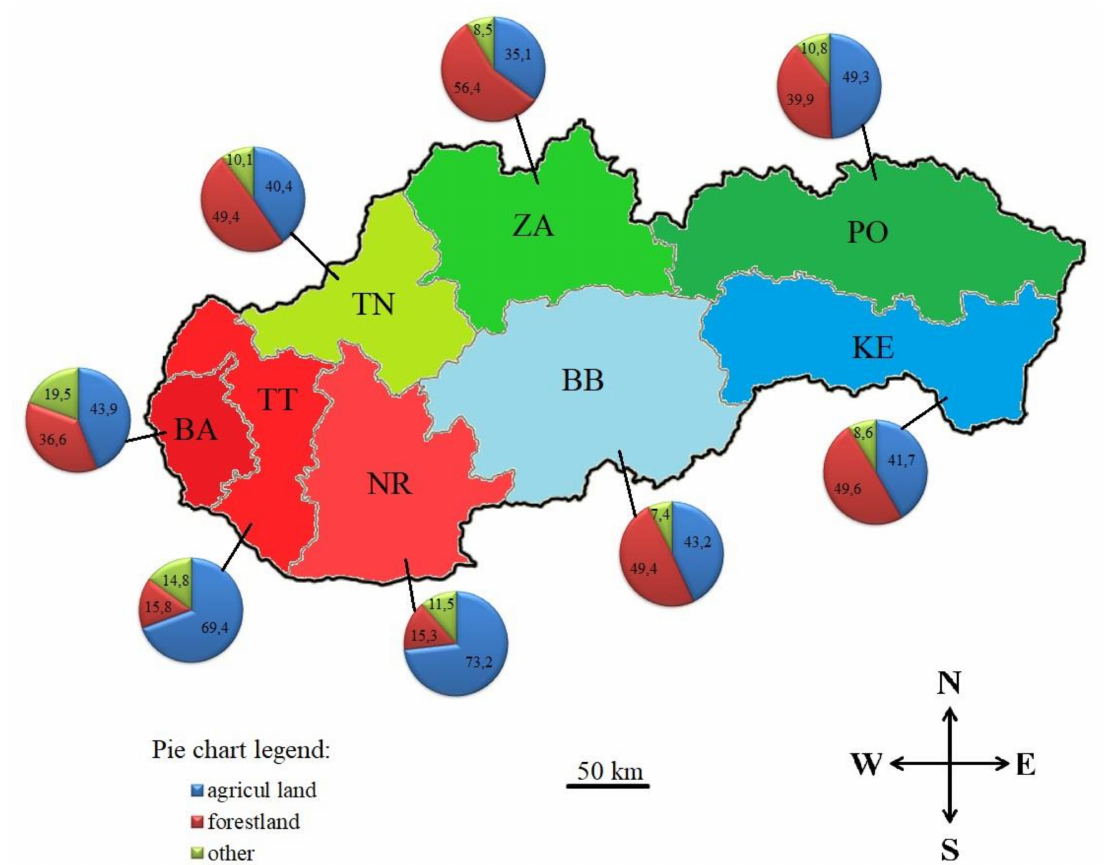
Figure 1. Share of agricultural land on the total area of a particular region (NUTS III) in 2019 (%). Source: own calculations on the basis of data from Statistical Yearbook on Land Fund in the